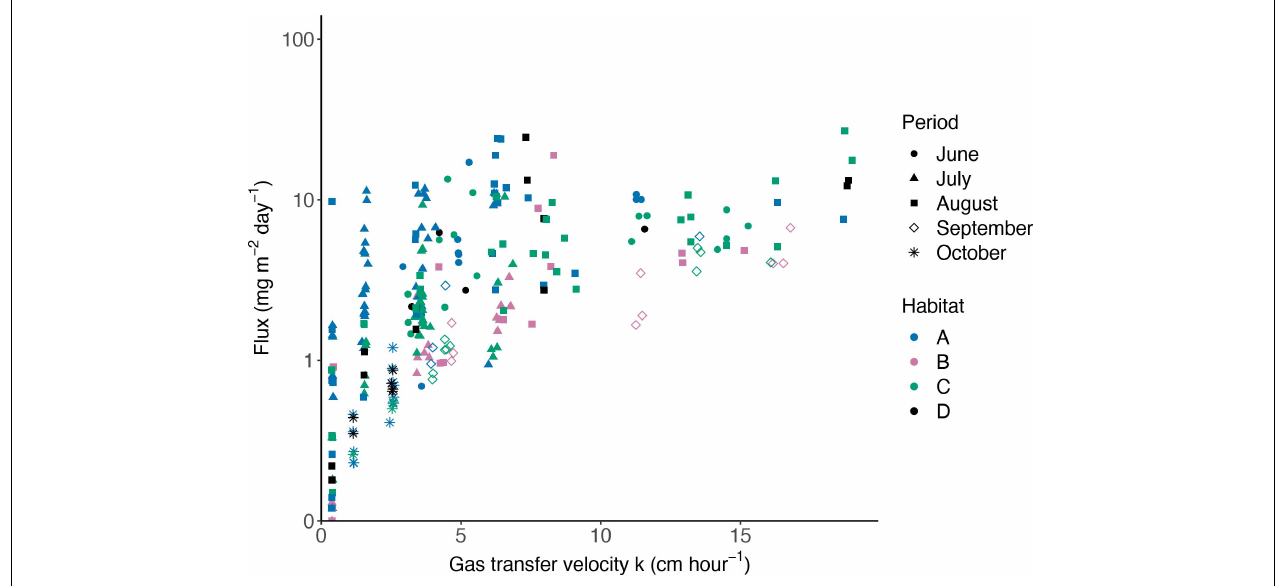
FIGURE 5 | Relationship between gas transfer velocity k and CH 4 flux calculated with the gas transfer velocity model. The variability in flux for a given k -value indicates the strong water-side CH 4 concentration dependence of the flux. The concentration variability may include captured microbubbles of CH 4